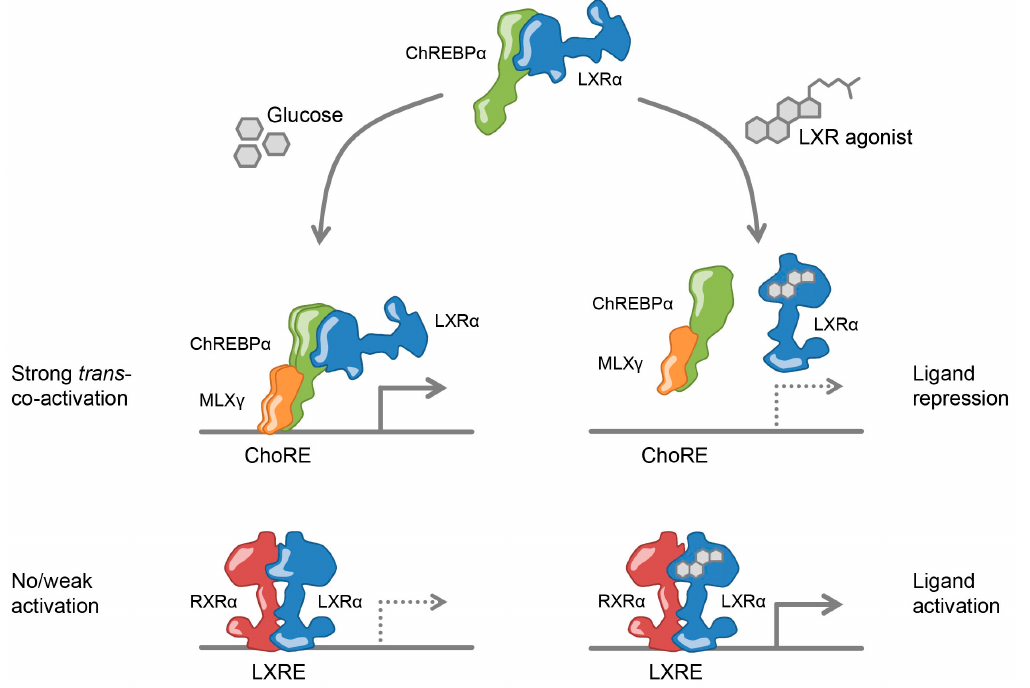
Figure 7. Model of transcriptional co-regulation by LXR α and ChREBP α .